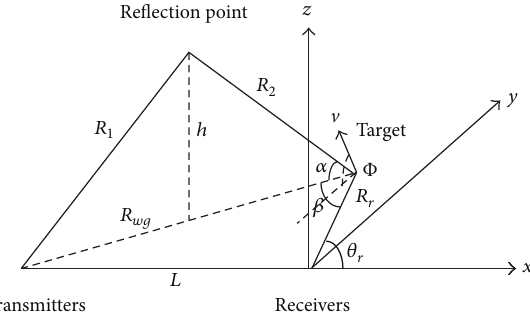
Figure 1:Thegeometrical model of theHF sky-surfacehybrid